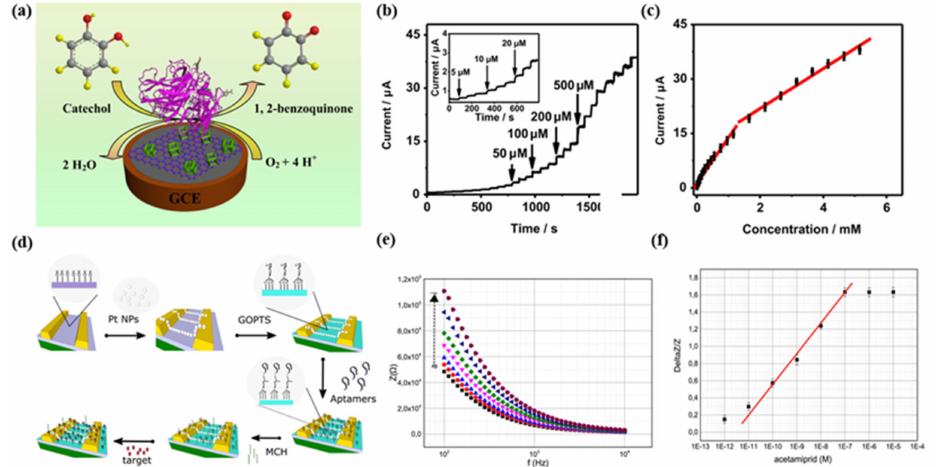
Figure 2. ( a ) Schematic design of the catalyzed oxidation on the catechol (analyte) electrode surface by laccase. ( b ) The proposed calibration curves of the catalytic currents vs. catechol (analyte) concentrations; and ( c ) calibration curve (Adapted from [98]) based on amperometric responses; ( d ) Schematic design of surface functionalization, where the Thiol-modified aptamers are bonded covalently and immobilized on the surfaces; ( e ) The Bode plots of the functionalized sensors; ( f ) The calibration curves are obtained for pesticides, such as acetamiprid (reproduced with the permission of